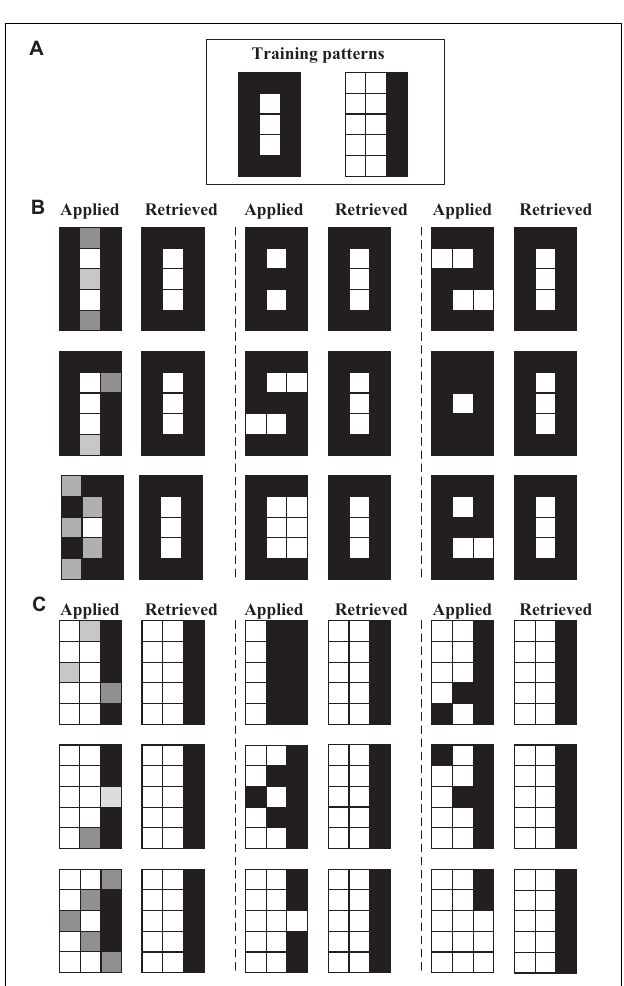
FIGURE 9 | 5 × 3 ONN experiment. (A) Training patterns. (B,C) Applied and retrieved patterns corresponding to “0” and “1,” respectively.